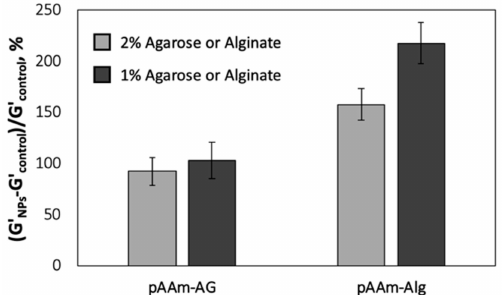
Figure 3. Relative elastic moduli of pAAm-agarose (pAAM-AG) and pAAM-alginate (pAAM-Alg)